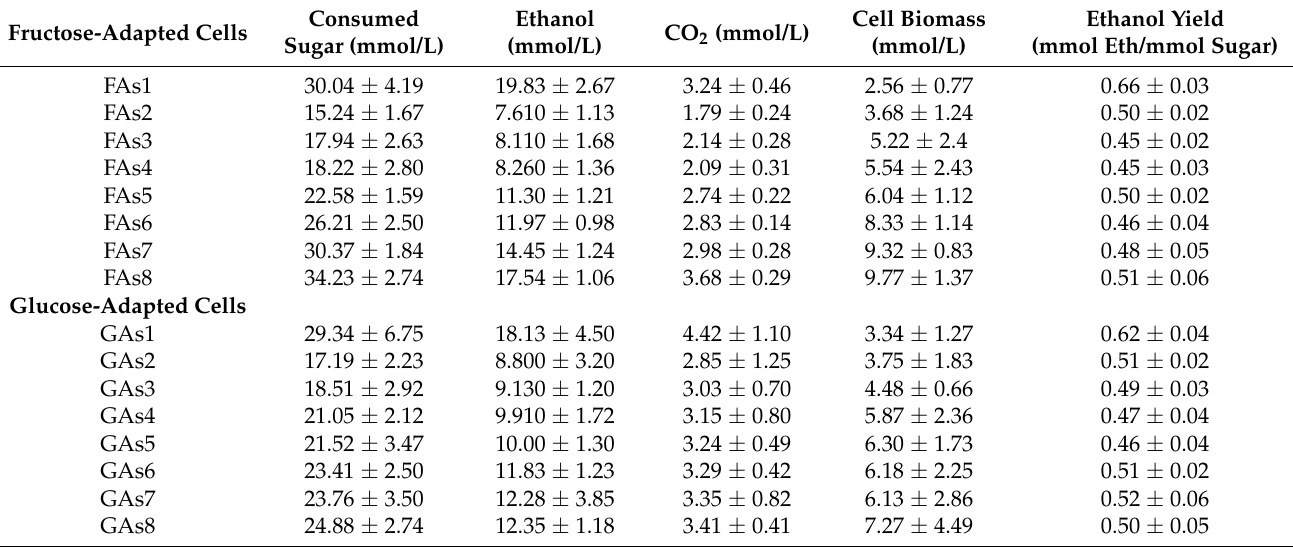
Table 1. Hexose sugars consumption, ethanol and CO 2 production, cell biomass and ethanol yield after seven sequential transfer events.